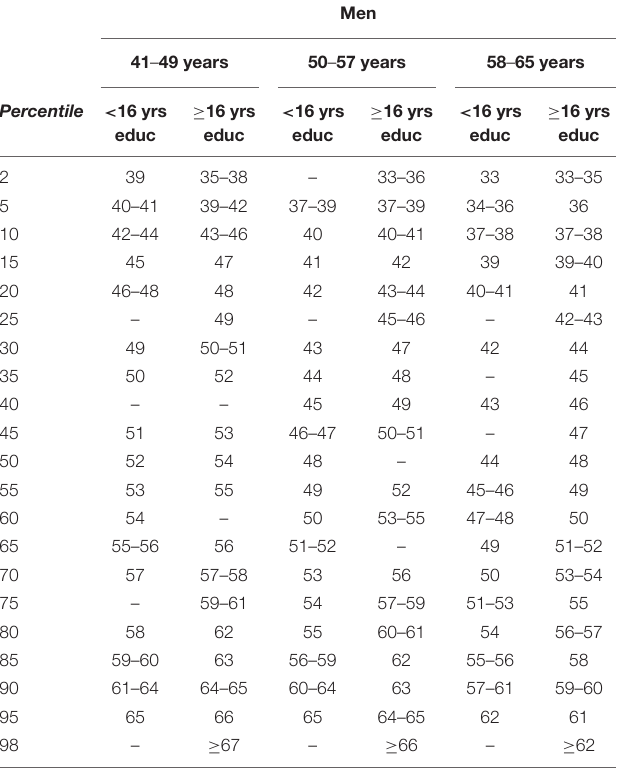
TABLE 9 | Normative data for men performance on RAVLT Delayed